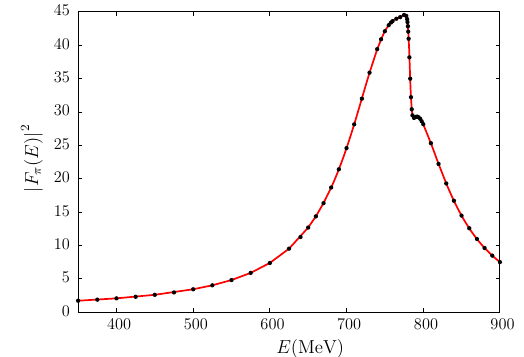
Fig. 4 The EM charged pion form factor calculated by direct calls to the subroutine for F π ( s ) ( points ) and with the MC program generated automatically ( solid line )